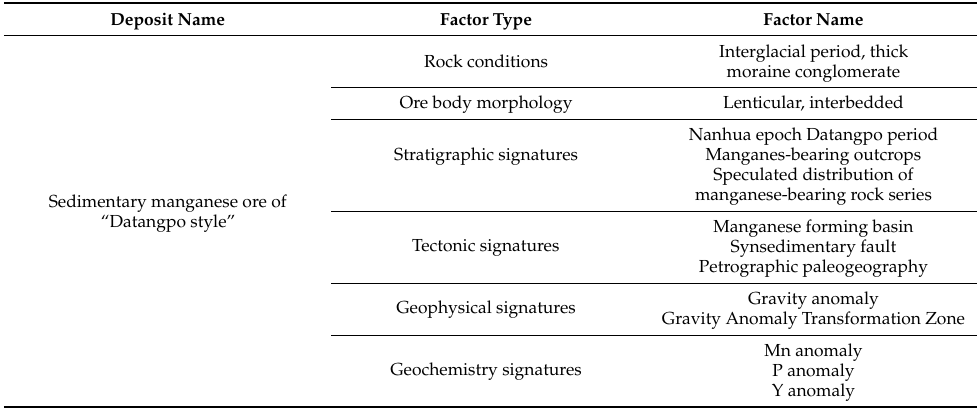
Table 8. Songtao-Huayuan manganese ore conceptual prospecting